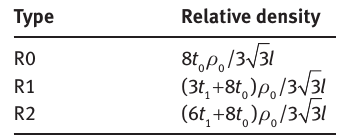
Table 2: Apparent densities for HCs.